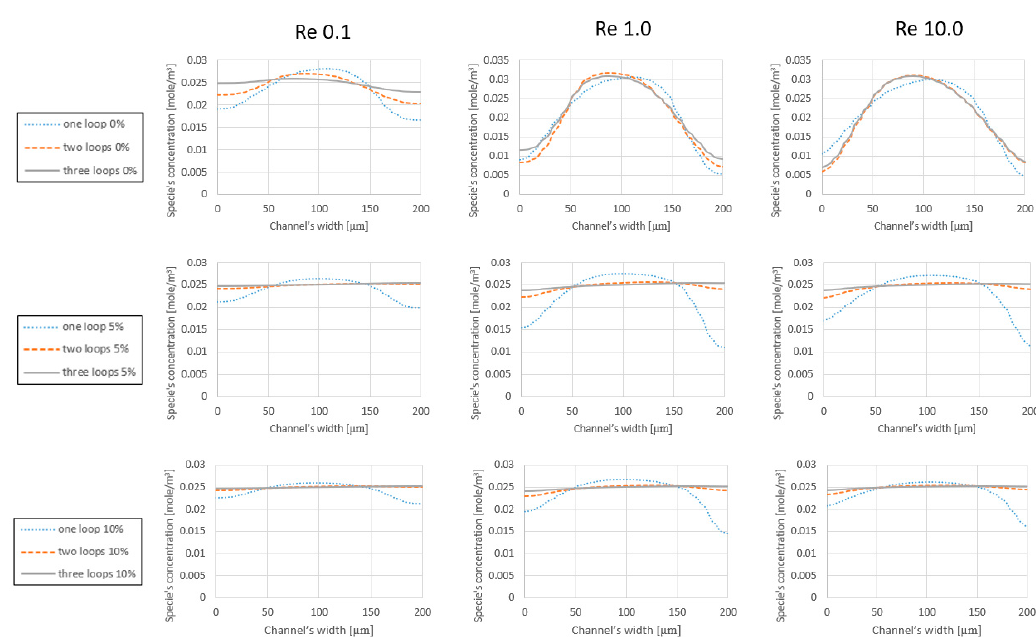
Figure 4. Species concentration at the outlet of the mixer. At each row, mixer types with similar expansion rates are compared with respect to the operating conditions, which are Re 0.1, Re 1.0 and Re 10.0. Regarding the definition of mixing, a straight horizontal line on the level of 0.025 (mol)